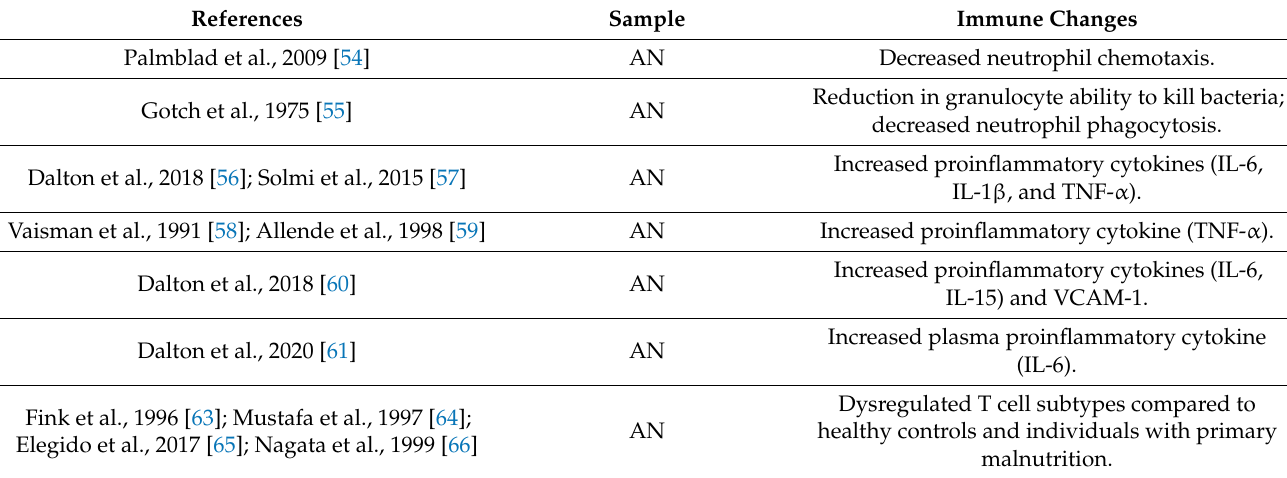
Table 2. Summary of peripheral and central immune changes in anorexia nervosa (AN) and animal models of